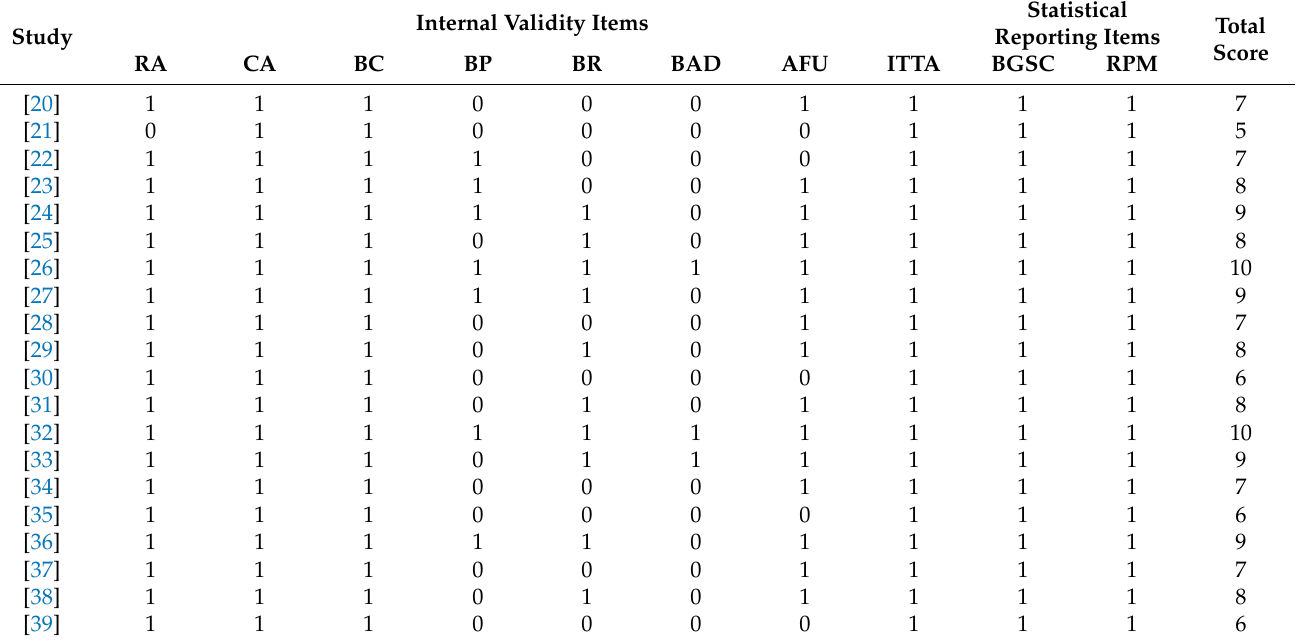
Table 1. Physiotherapy Evidence Database scale score of the full texts of the screened studies.